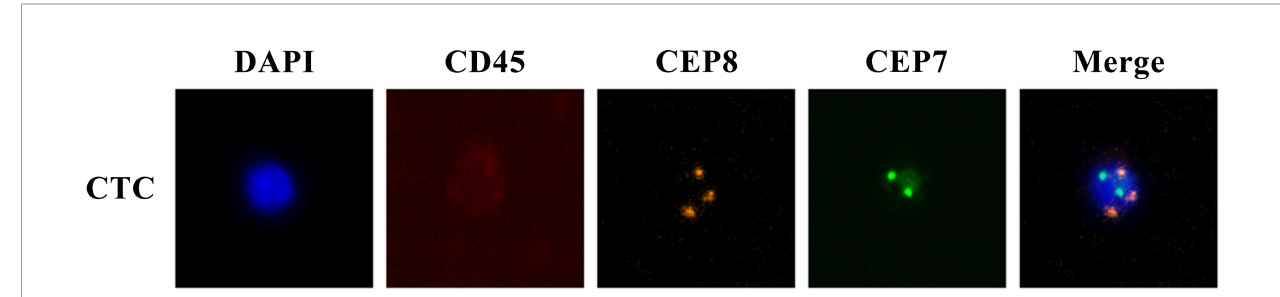
FIGURE 1 | CTC images under fl uorescence microscope identi fi ed by NE-FISH.